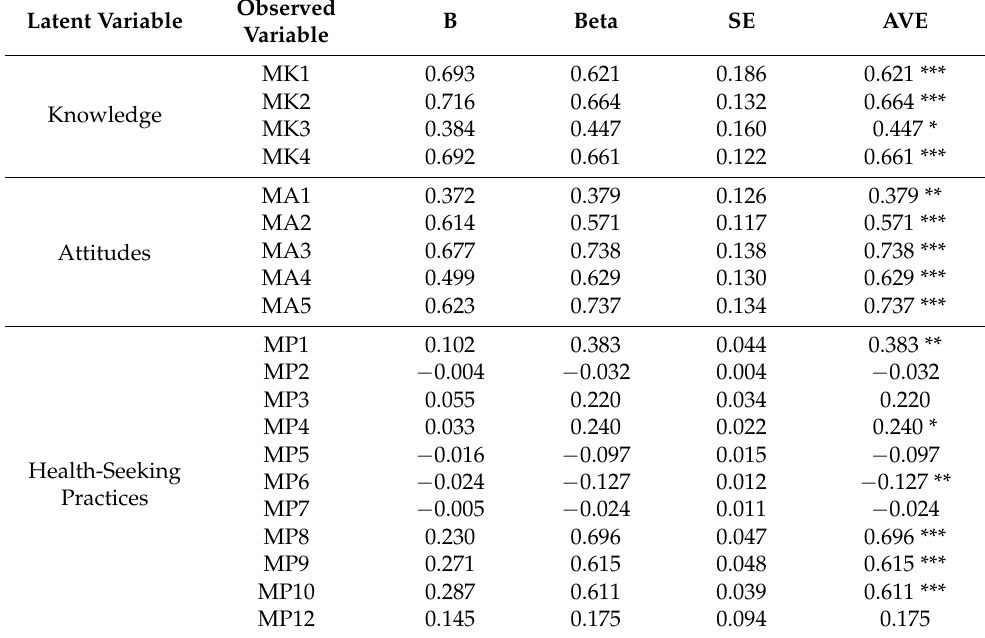
Table 3. Results of confirmatory factor analysis of facility managers to validate the pooled measure- ment model.